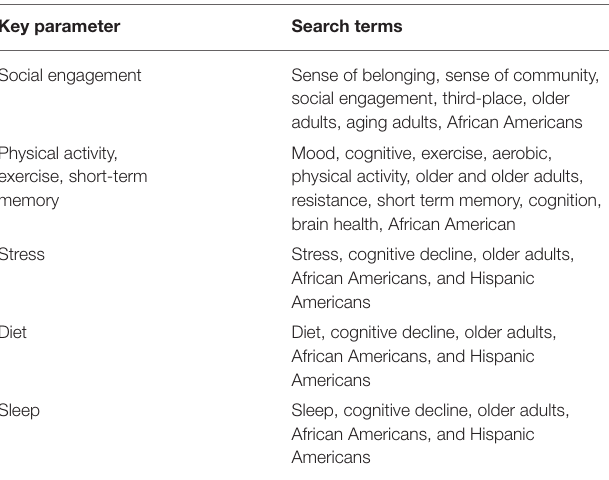
TABLE 1 | Key Parameters of